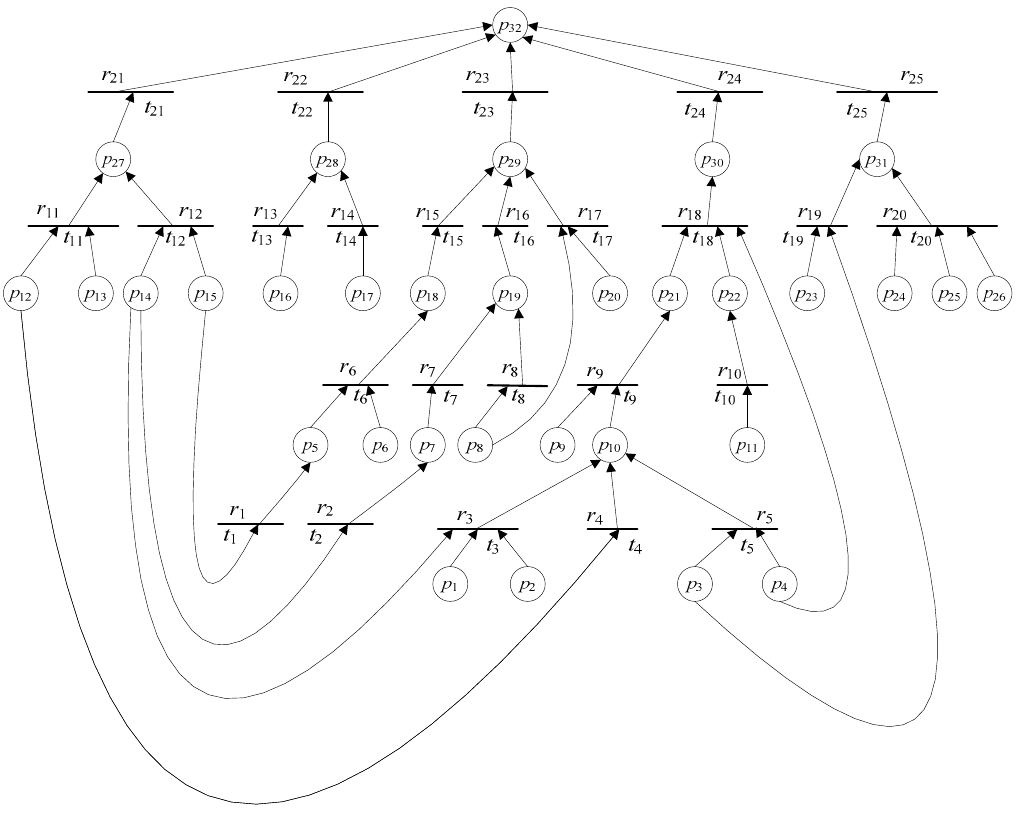
Figure 6. Fuzzy reasoning Petri Net (FRPN) model of the CNC machine tool. Table 2. p i and θ i of the fuzzy reasoning Petri Net (FRPN) model for the CNC machine